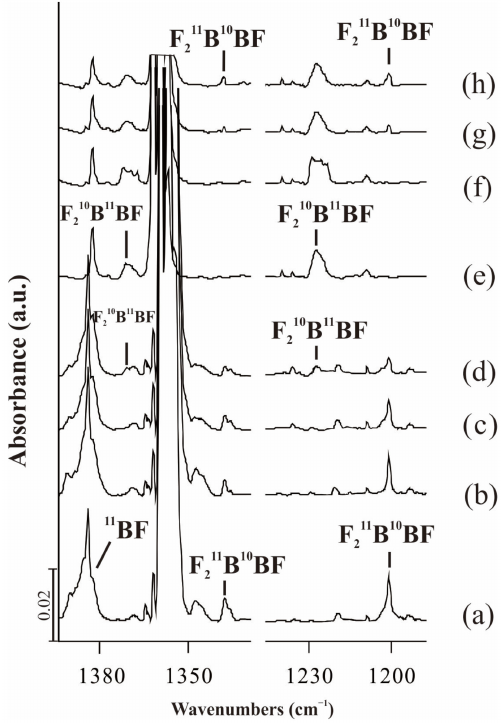
Figure 2. Infrared spectra of the laser-ablated B react with BF 3 in excess solid neon. ( a ) co-deposition of 10 B + 1.0% 11 BF 3 for 60 min; ( b ) after annealing to 8 K; ( c ) after λ > 300 nm irradiation for 6 min; ( d ) λ > 220 nm irradiation for 6 min; ( e ) co-deposition of 11 B + 0.5% 10 BF 3 for 60 min; ( f ) after annealing to 8 K; ( g ) after λ > 300 nm irradiation for 6 min; ( h ) λ > 220 nm for irradiation for 6 min.